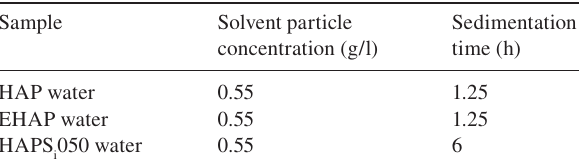
Figure 6 Infl uence of silica-coating HAP on the zeta potential vs. pH value curve for